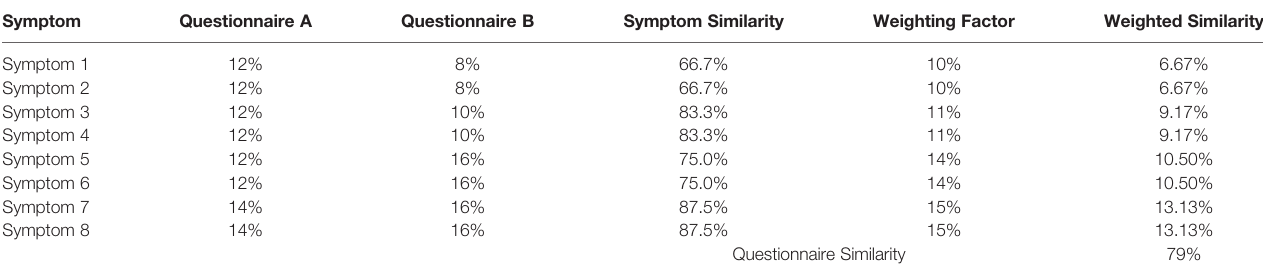
TABLE 2 | Simulated example of symptom similarity computation. Symptom Questionnaire A